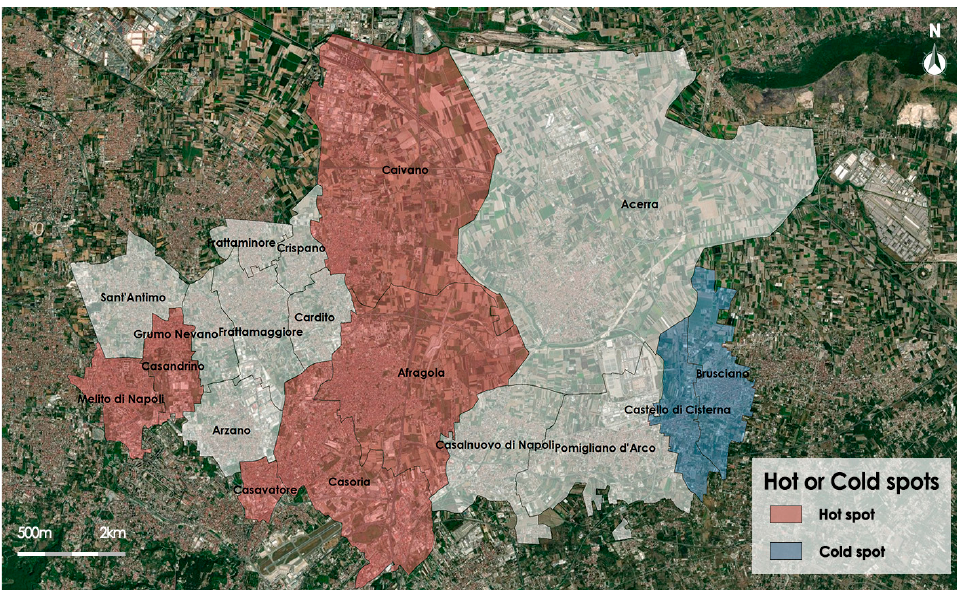
Figure 9. Map of Hot and Cold spots in the study area.